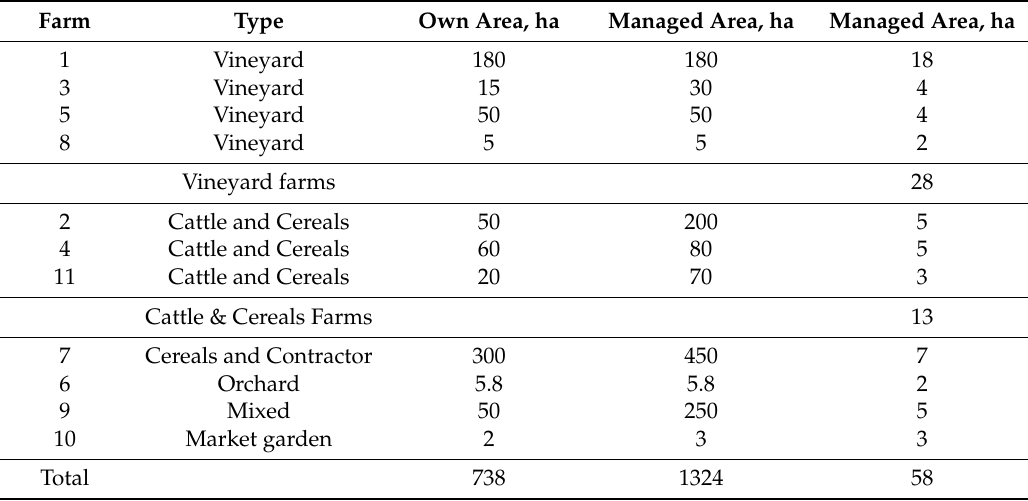
Table 7. The sample farms in the second